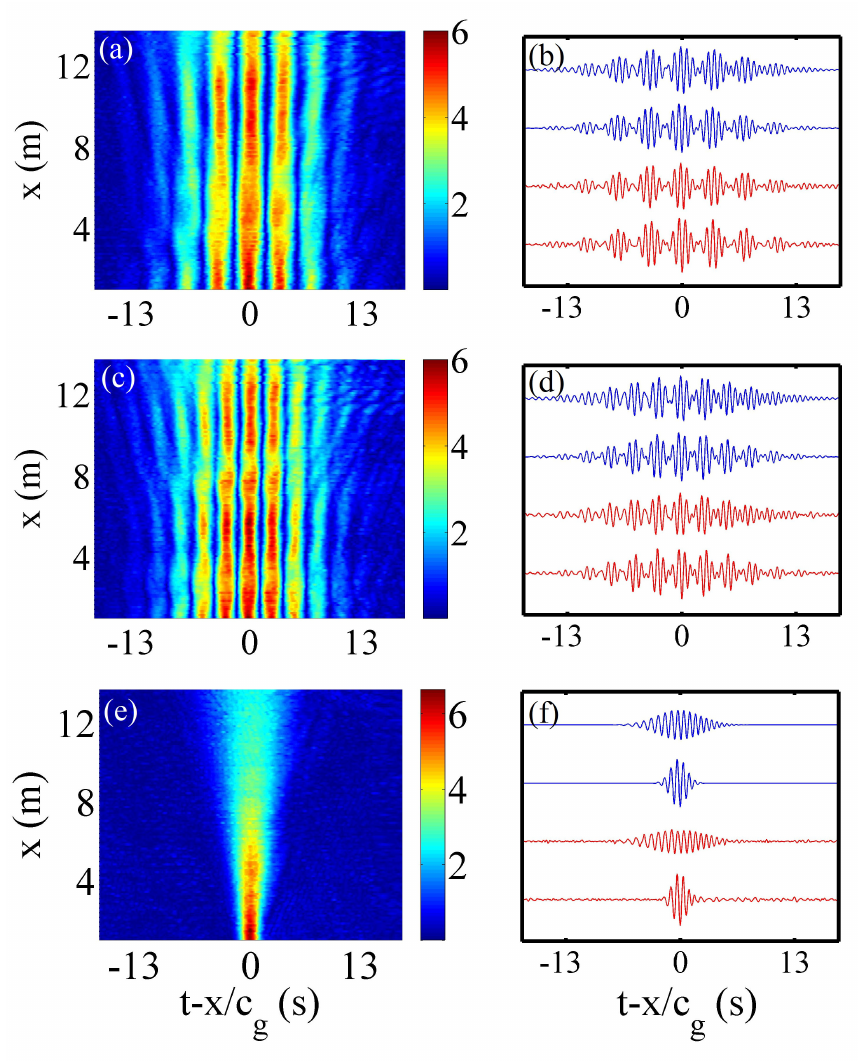
Figure 8. Propagation dynamics of cosine-Gauss pulses along the tank presented in Figure 7 with a 0 = 6 mm ( ε = 0.05), θ = 5.5 ◦ , and t 0 = 9.0 s ( a , b ) and θ = 5.5 ◦ for ( c , d ). ( a , c ) Experimental results on pulse envelopes obtained by the Hilbert transform in a frame of reference moving at velocity c g ; ( b , d ) temporal variation of the surface elevation at two locations; ( e , f ) Gaussian pulse evolution, the initial width of the Gaussian pulse as in ( a